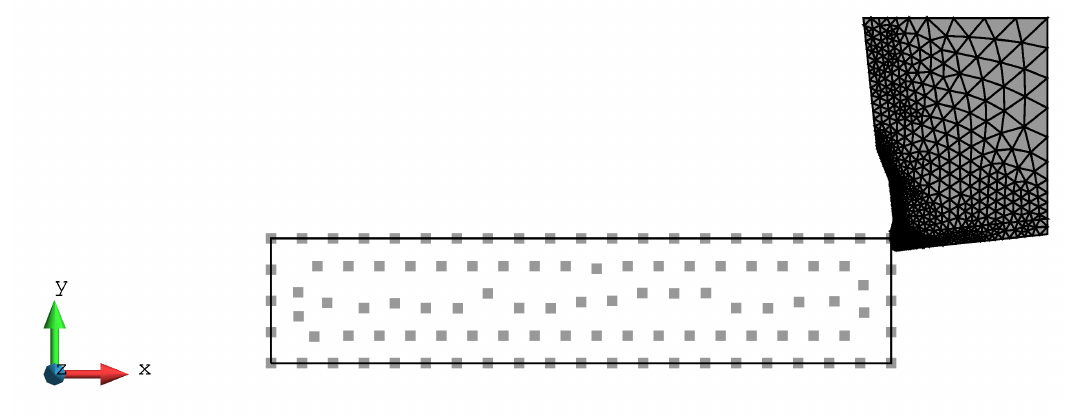
Figure 6. Mesh used to create the particles at the beginning of the simulation. Feed 0.05 mm. Dimensions are in mm.